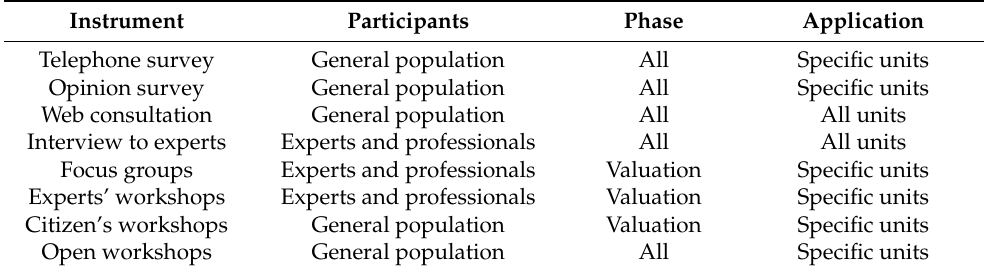
Table 2. List of instruments, phases and type of citizen participation in Catalonia.